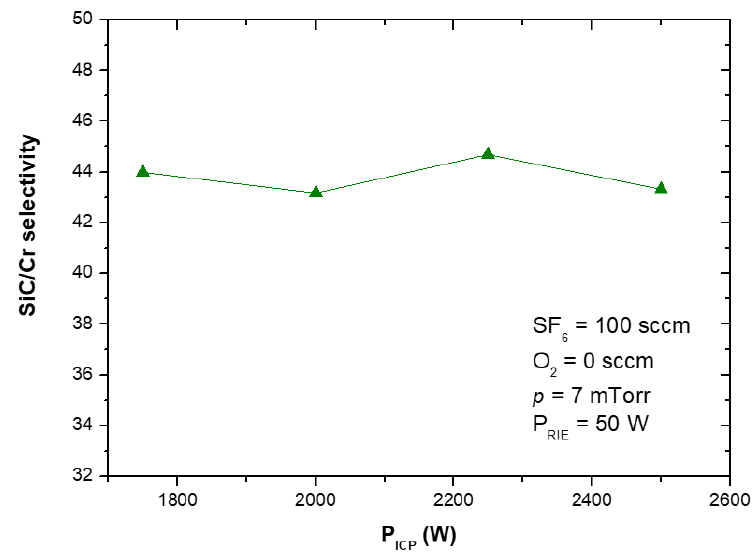
Figure 17. SiC/Cr selectivity as a function of ICP power applied. Fixed parameters are included in the inset.